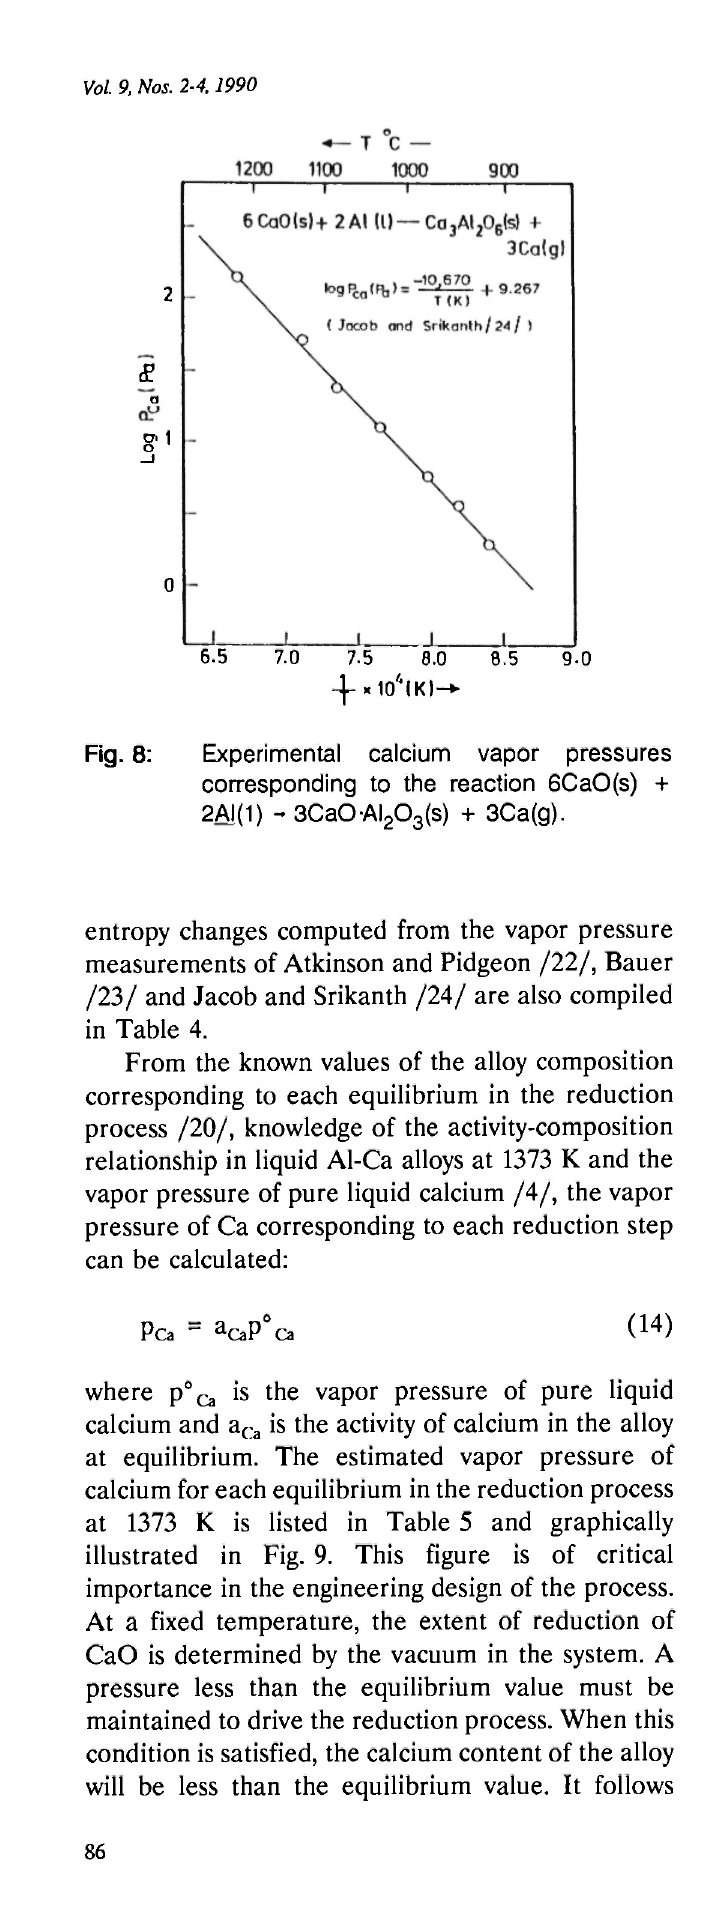
Fig. 9: Equilibrium calcium vapor pressures at 1373 Κ corresponding to the different end products in the "aluminothermic" reduction of